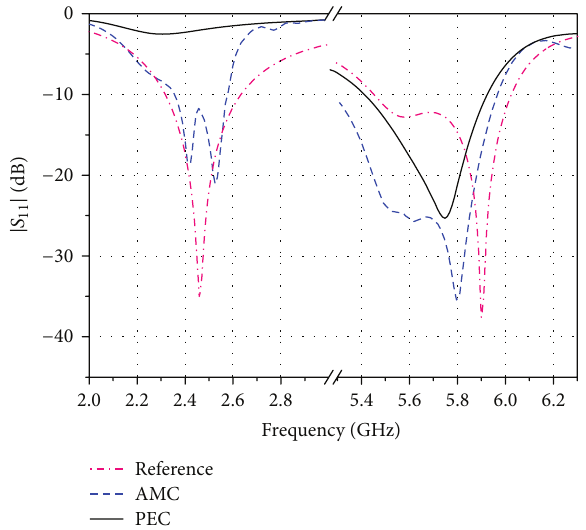
Figure 10: Comparison of |𝑆11| between antenna with and without modified GND.